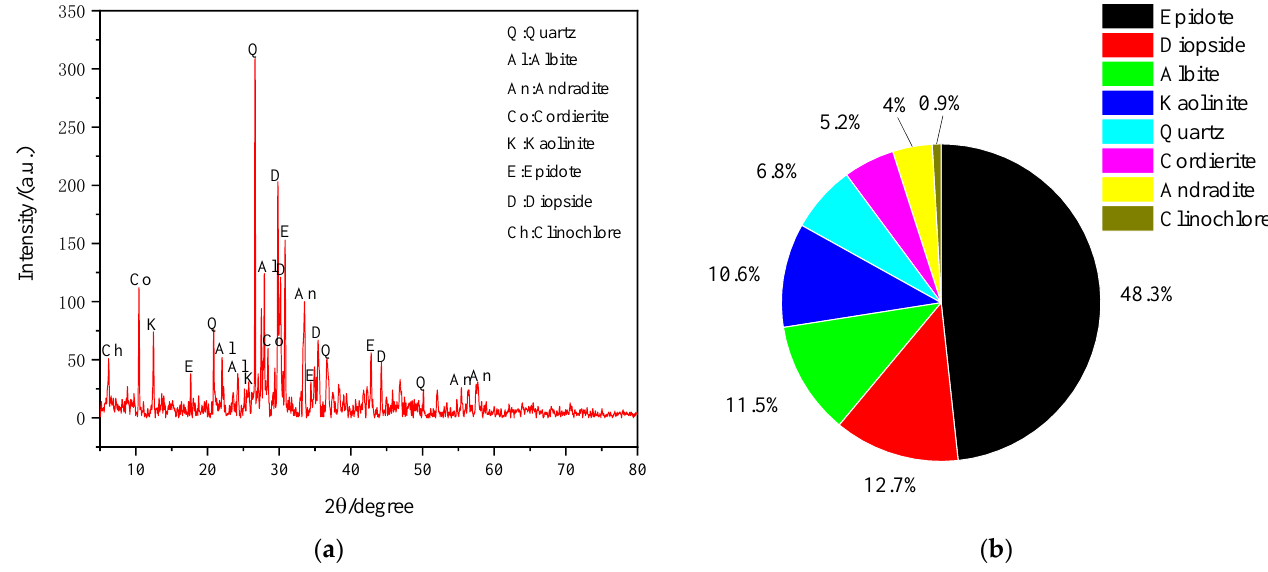
Figure 15. ( a ) XRD pattern of mineral dust. ( b ) Glacial dust mineral content.